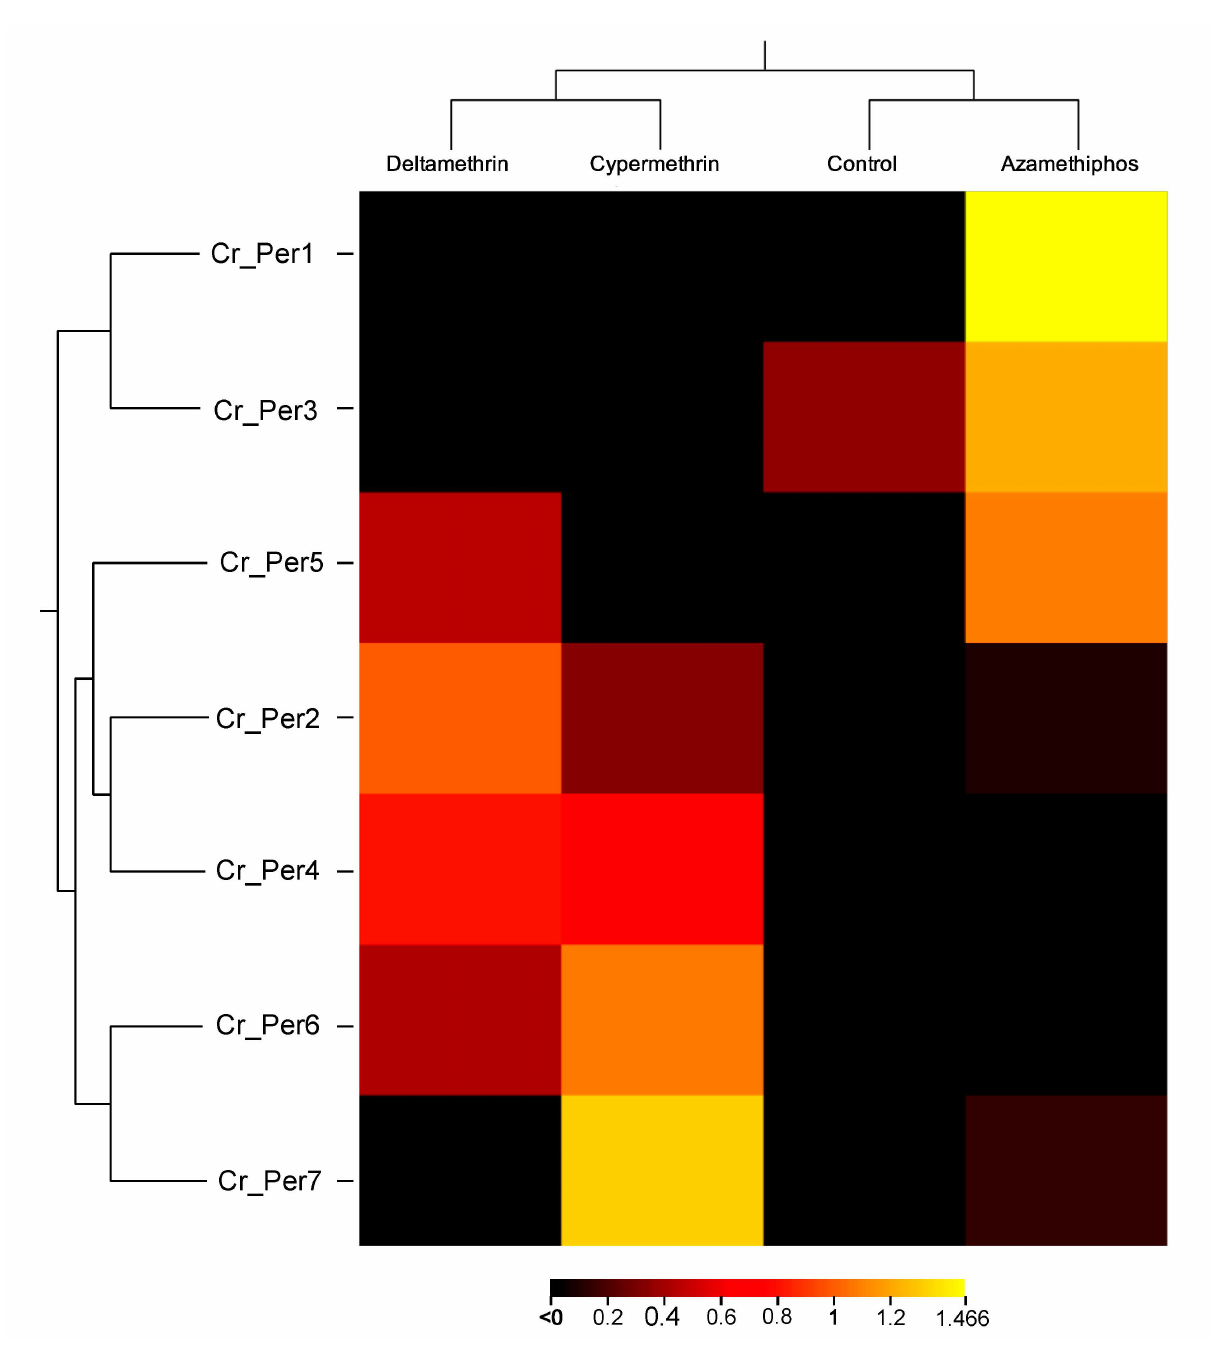
Figure 4. Heatmap of gene transcription values from drugs-exposed C. rogercresseyi to 100 ppb of azamethiphos, 3 ppb deltamethrin, and 15 ppb cypermethrin. Transcript abundance is represented as TPM values. Color scales show relative transcript expression. Hierarchical clustering was conducted based on Euclidean distance for TPM data with an average